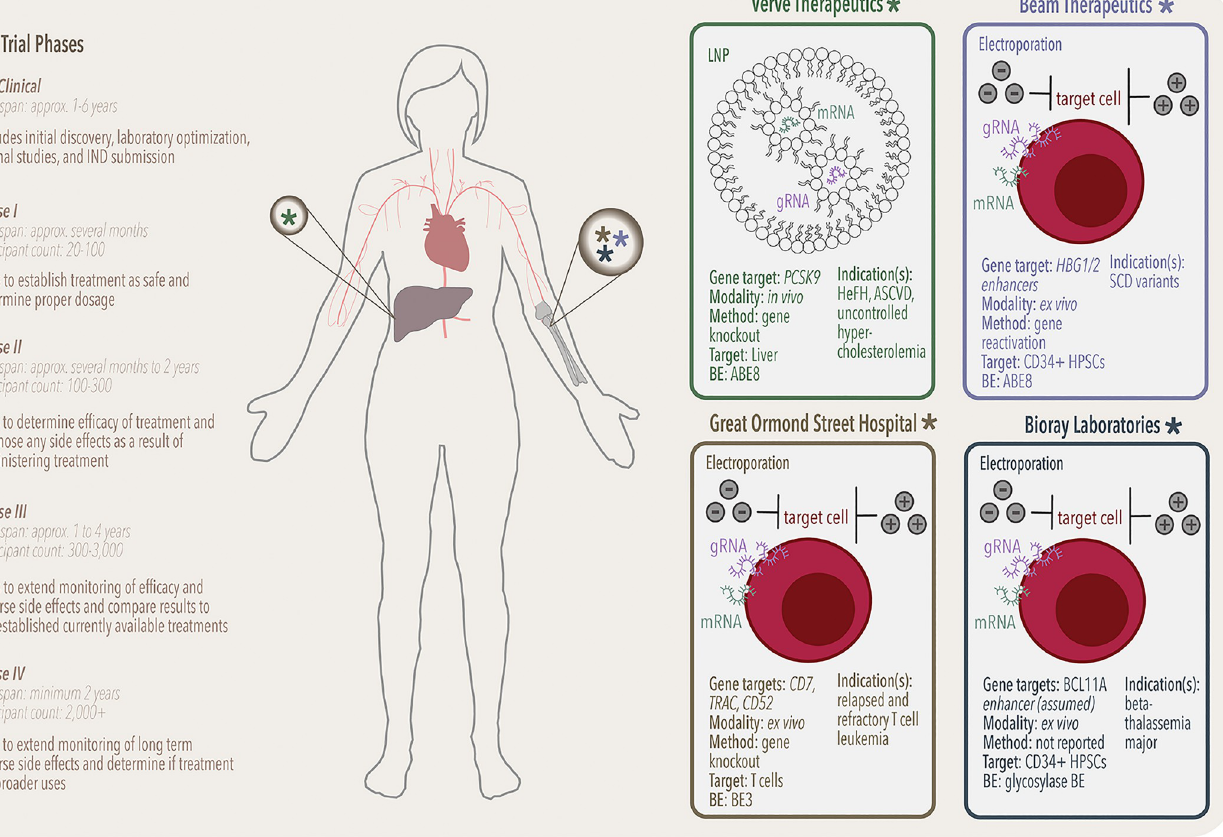
Fig 3. Overview of current base editing clinical trials. Left : a simplified timeline for the path of a drug from preclinical to FDA approval. Current statuses of ongoing trials are represented by colored special characters: ^ are clinical candidates in development, while * are candidates currently undergoing clinical trials sponsored by Verve Therapeutics (forest green), Beam Therapeutics (mauve), Great Ormond Street Hospital (mustard), and Bioray Laboratories (navy). Middle : a visual representation of the target of each of the four clinical trials; a single in vivo treatment is delivered to the liver (forest green) and three others function by ex vivo treatments, which are then subsequently readministered via bloodstream IV and will repopulate cells in the bone marrow (mauve, mustard, navy). Right : detailed breakdown of the four ongoing clinical trials. Shown are the delivery modality (mRNA (teal)/gRNA (purple) electroporation versus lipid nanoparticle delivery), as well as targeted